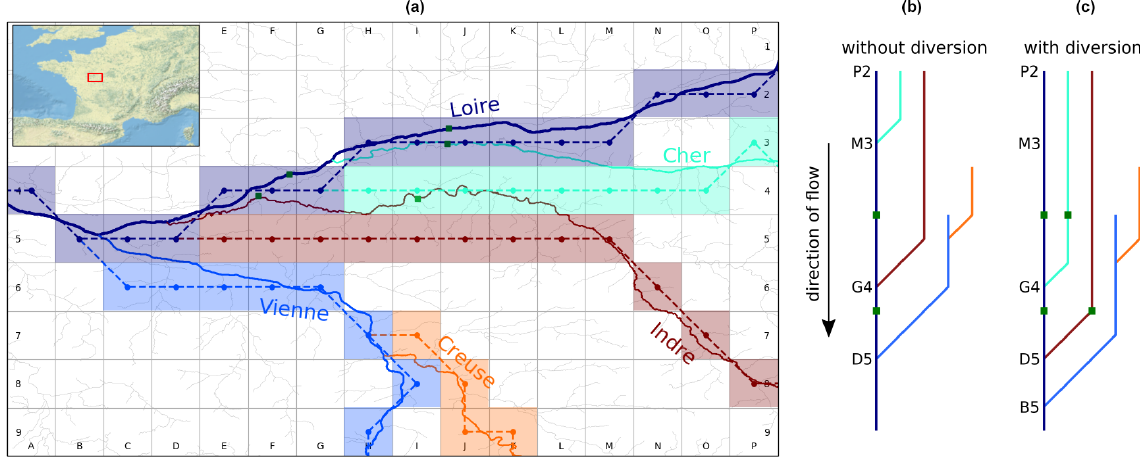
Figure 3. (a) Example of river diversions within the Loire River basin (France); (b, c) directional trees of the river network shown in (a) . As in Fig. 2, rivers are treated in descending order of drainage area: (1) the Loire River (dark blue), (2) the Vienne River (light blue), (3) the Cher River (green), (4) the Creuse River (orange) and (5) the Indre River (red). Solid lines and dashed lines represent rivers at HR and 12D, respectively. Green squares represent gauge stations.